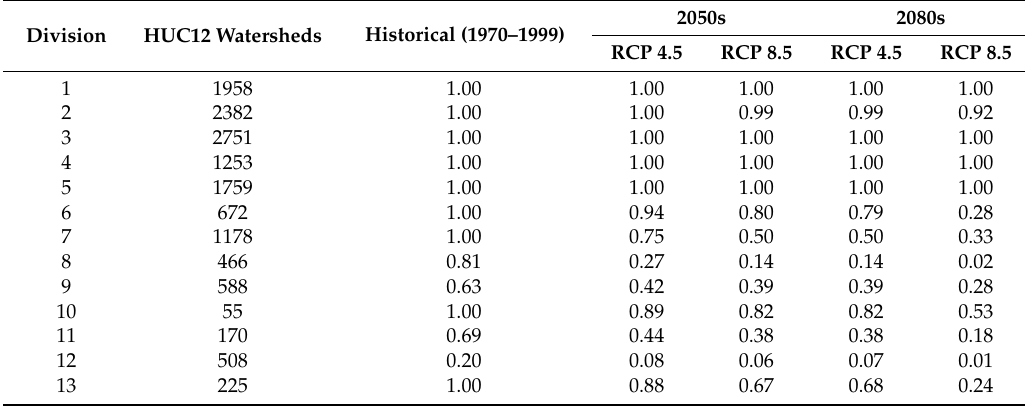
Table 7. Fraction of HUC12 watersheds with snow dominated SFE:P ( ≥ 0.4) by Alaska Climate Division and climate